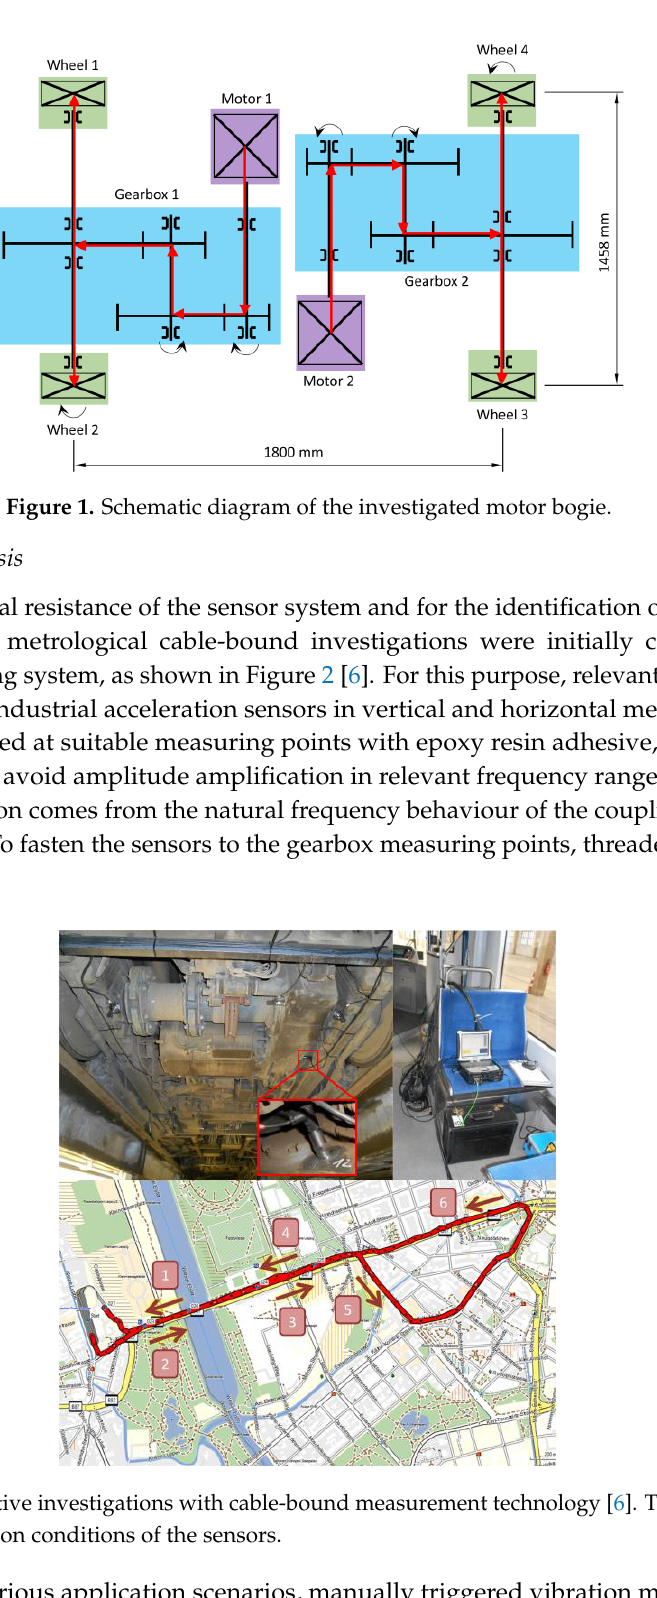
Figure 1. Schematic diagram of the investigated motor